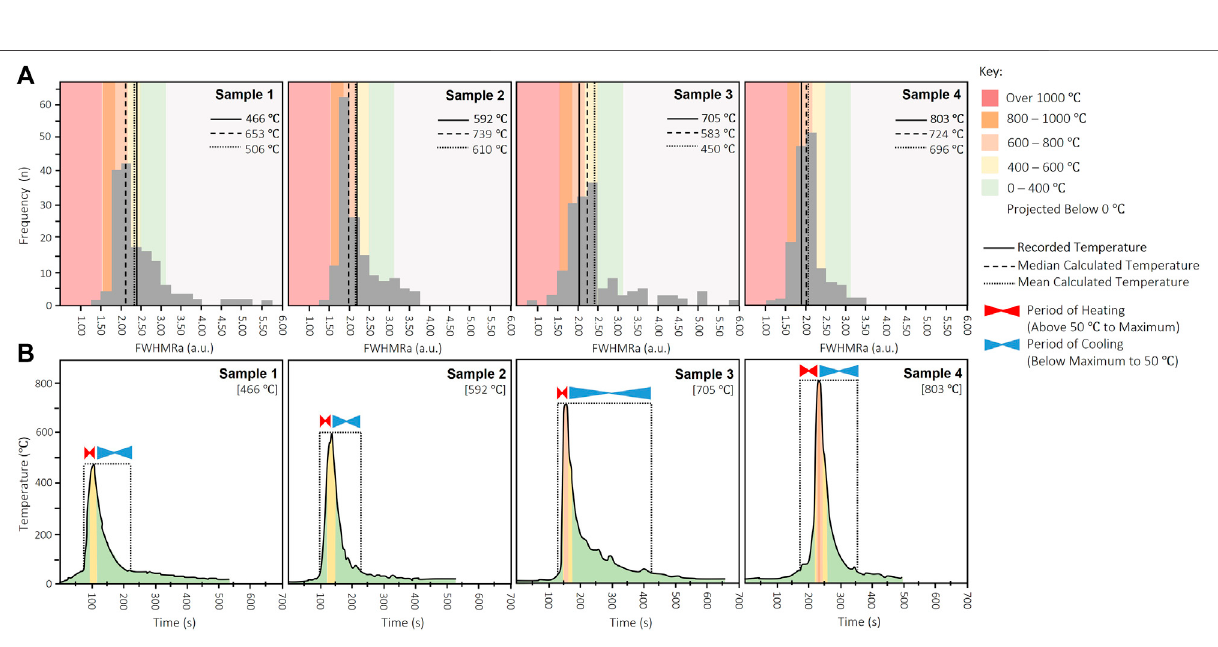
FIGURE 4 | Comparative diagrams corresponding to prescribed fi re geothermometry, presenting; (A) the nature of Raman data distribution for each sample set, relative to the expected versus mean and median FWHMRa values, and (B) fl ame time-temperature plots denoting periods within certain temperature thresholds, and the cooling/heating periods relevant to